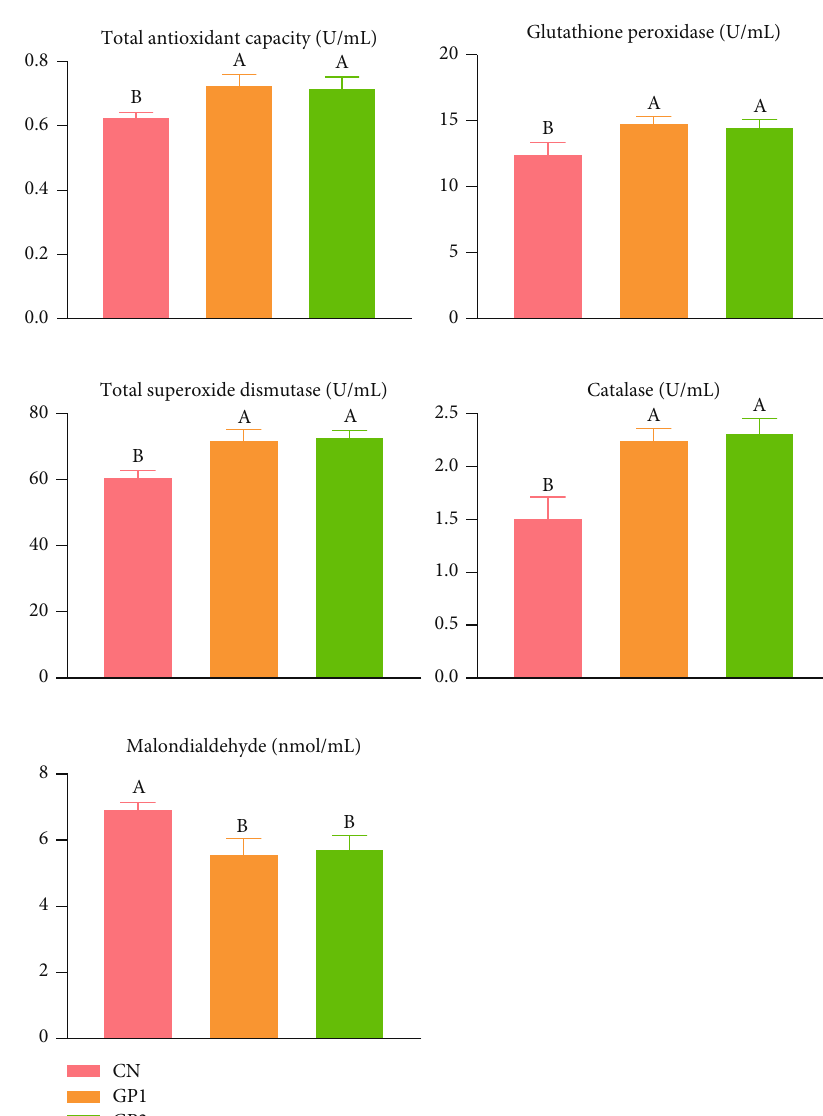
Figure 2: E ff ects of garlic powder inclusion on the antioxidant status of serum in Chinese mitten crabs. Bars assigned with di ff erent superscripts are signi fi cantly di ff erent ( P < 0 : 05 ); CN represents the control group that Chinese mitten crabs fed a basic diet; GP2 represents the group that the Chinese mitten crabs fed with 1000 mg/kg garlic powder in addition to the basic diet; GP2 represents the group that the Chinese mitten crabs fed with 2000mg/kg garlic powder in addition to the basic